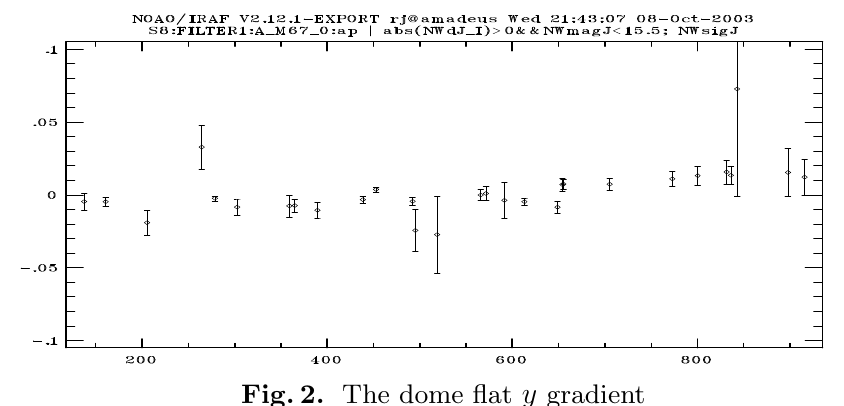
Fig. 2. The dome flat y